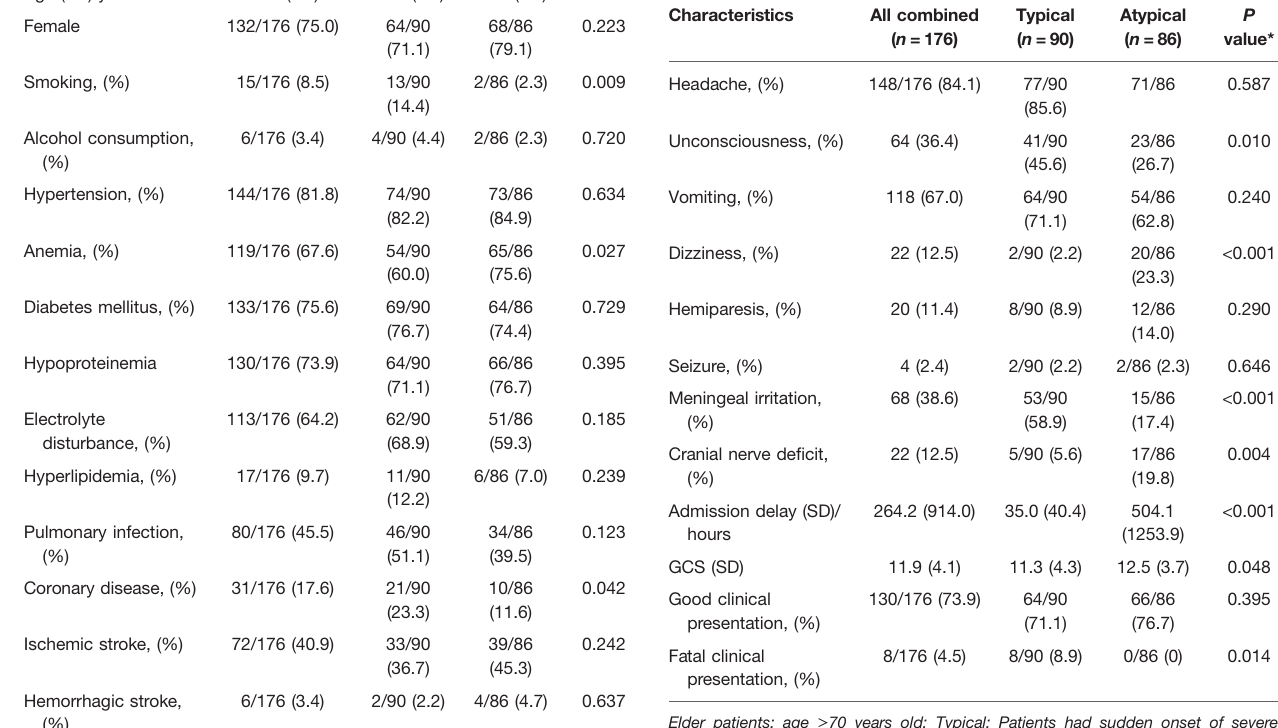
TABLE 2 | Clinical presentations of elder patients with ruptured intracranial